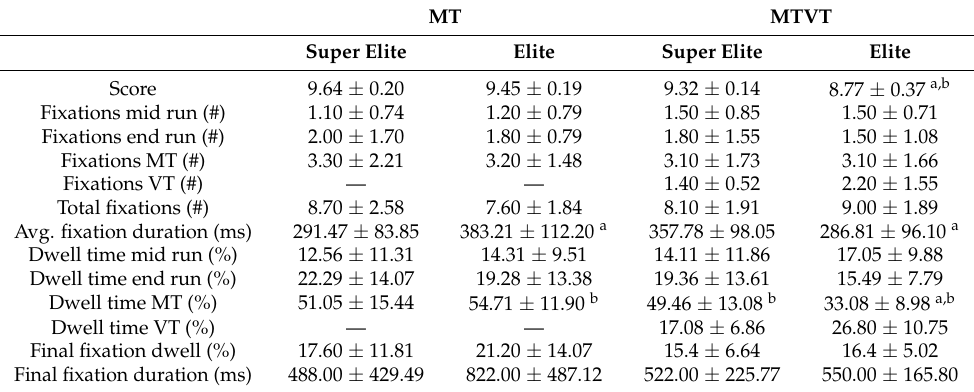
Table 1. The scores and gaze behaviour measures (mean ± SD) by group for vaulting skills executed using the mini trampoline without the vaulting table (MT) and with a vaulting table